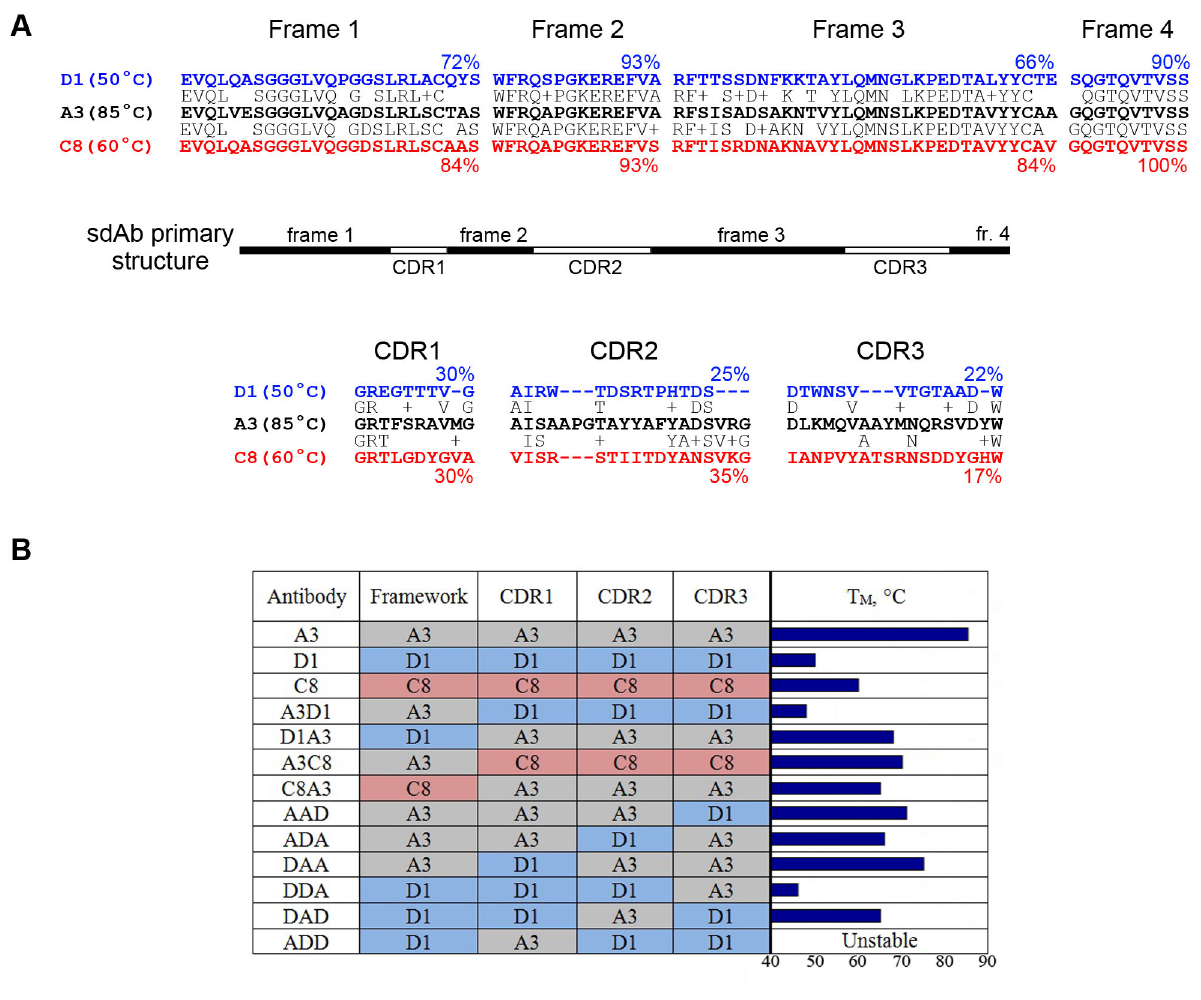
Figure 1. Primary structure and sequence of sdAbs used in this study. A) The overall primary structure of sdAbs is shown schematically with alternating framework and CDRs. Melting temperature for the wildtype sdAbs is given in parentheses next to the name. The framework regions are grouped together above the schematic while the CDRs are shown below. The percent identity of sdAb D1 and sdAb C8 toward sdAb A3 is shown for each region. B) Construct identifications are shown schematically for all hybrid antibodies in this study. Regions are color coded for clarity. Observed melting point is shown as a bar graph. Detailed measurements are presented in Table